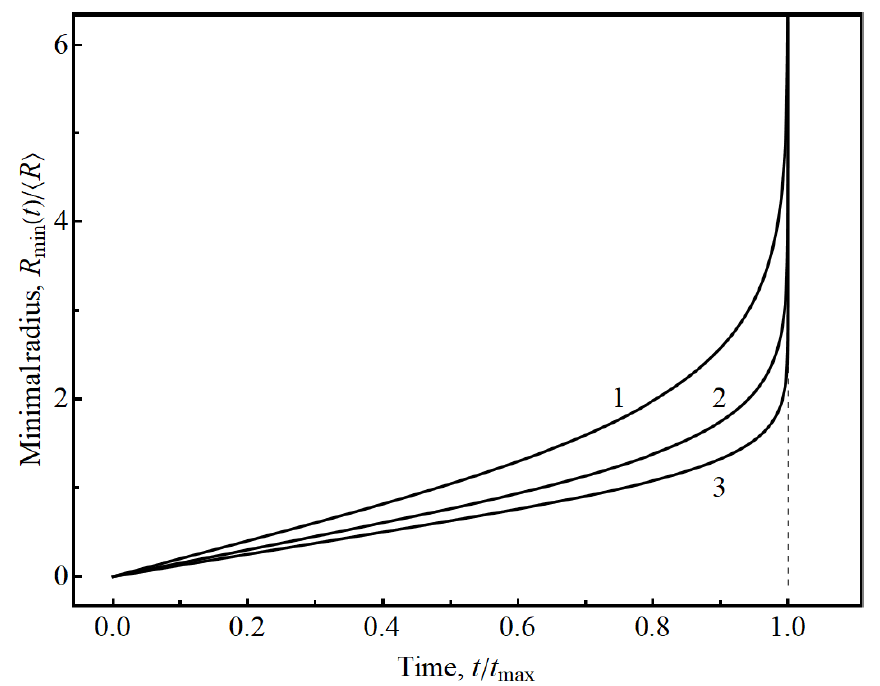
Figure 5. Dynamics of minimal radius R min of active particle in process of intercalation. Lines are the results of analytical solution (11) for di ff erent values of parameter m : (1) m = 2, (2) m = 4, (3) m =